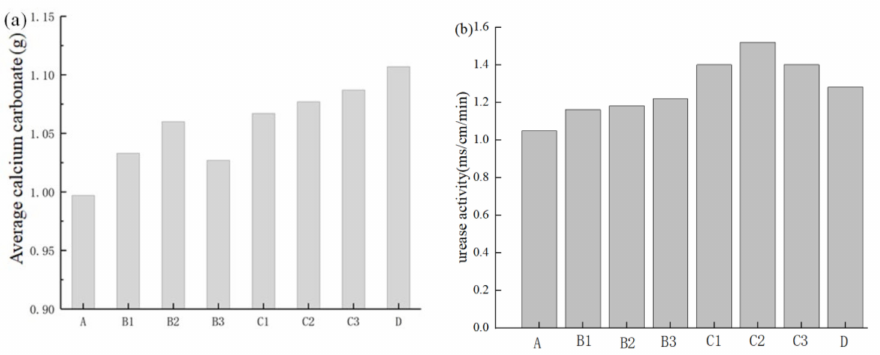
Figure 2. Average calcium carbonate content ( a ) and urease activity ( b ).